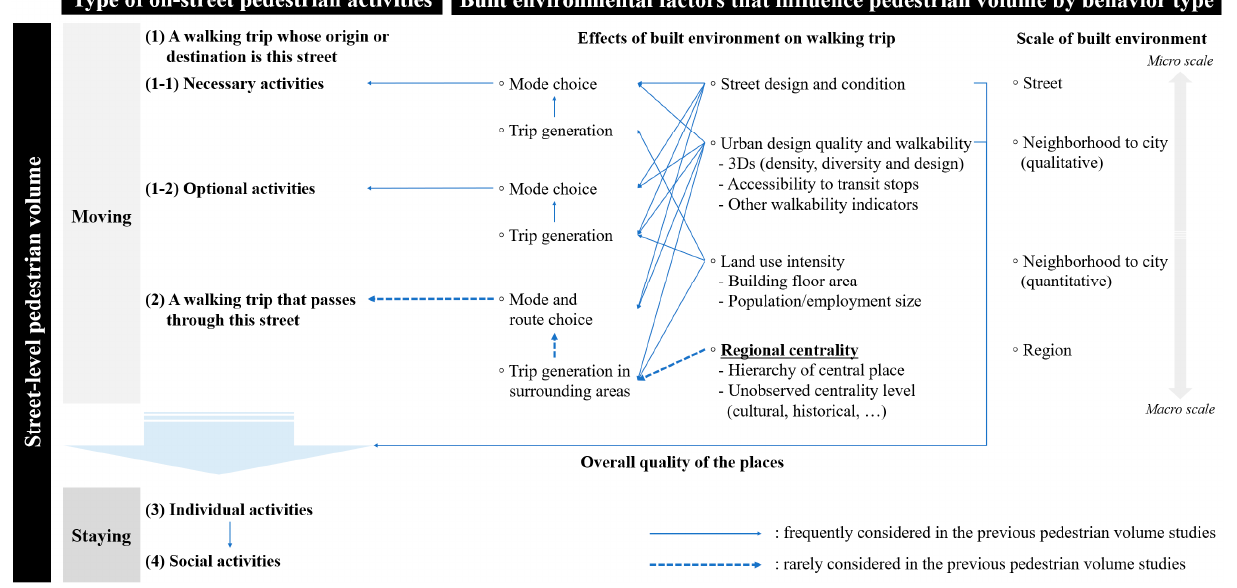
Figure 1. Pathways from built environment to street-level pedestrian volume: a conceptual framework.